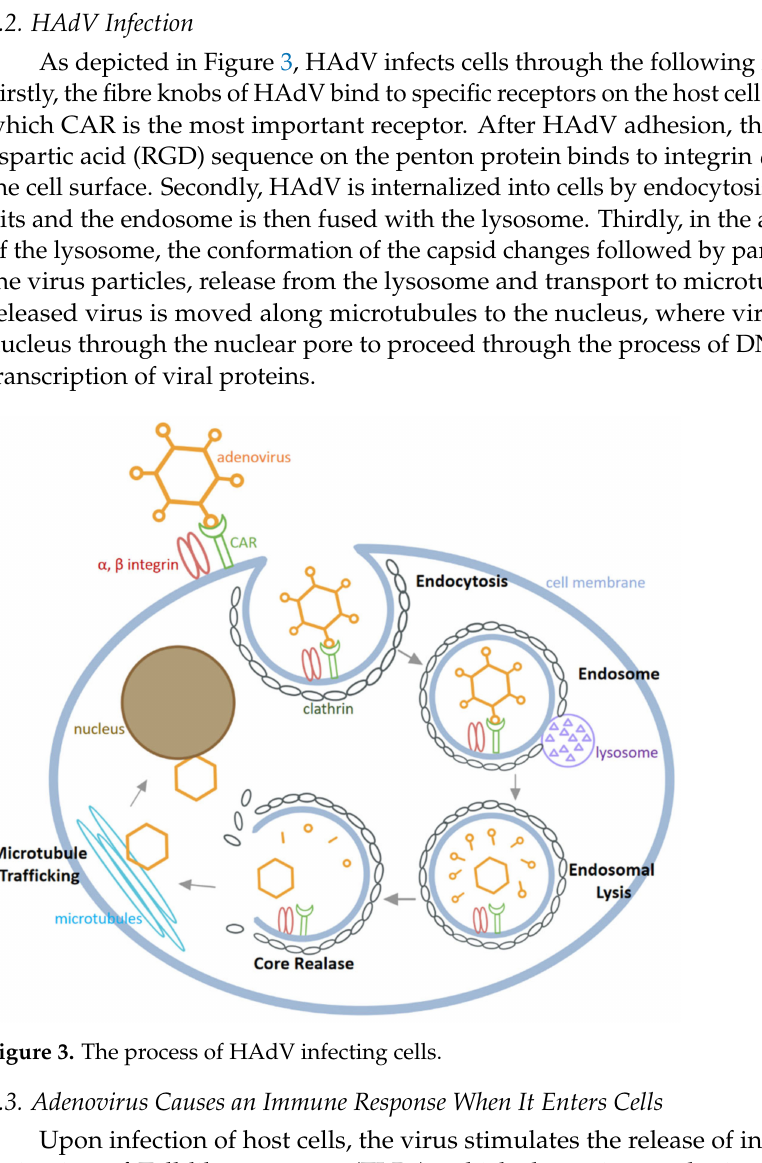
Figure 2. The genes and functions of HAdV.